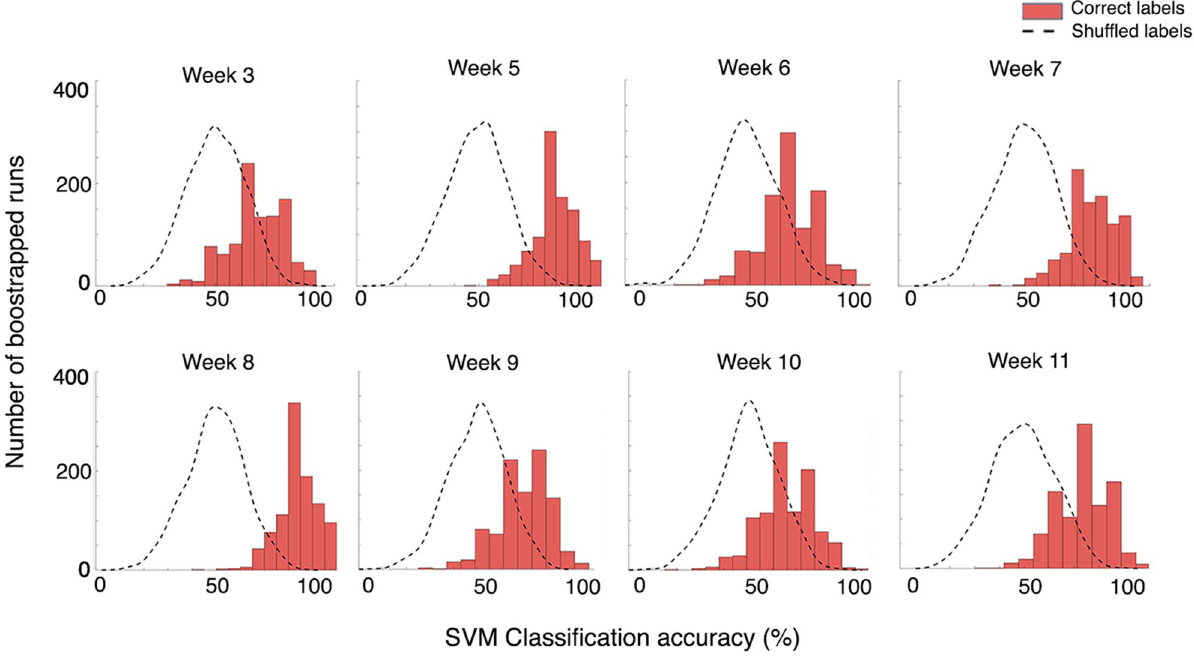
Figure 6. Histogram plots of classification accuracy across 1,000 bootstrapped SVM classifications. The SVM was able to classify between the (treated) left superior colliculus and the (untreated) right superior colliculus within α-synuclein rats, except at week 10. Plots of classification accuracy after shuffling labels are included. Here, accuracies fell around the 50%